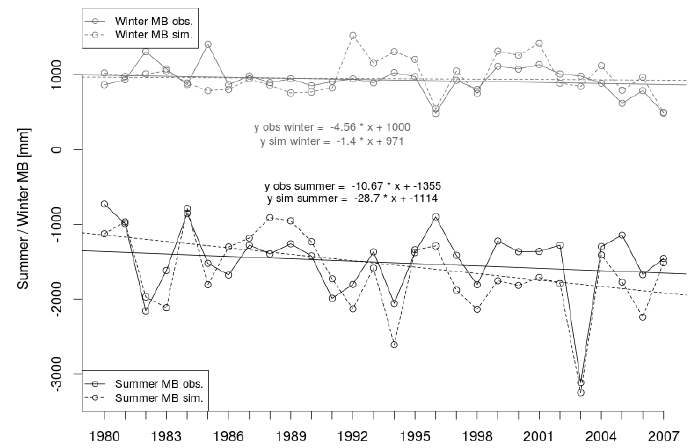
Figure 7. Simulated and observed summer and winter glacier mass balances (MB) of Vernagt glacier during the calibration period and linear trends (y obs/sim = observed/simulated mass balance; x = year—1979).